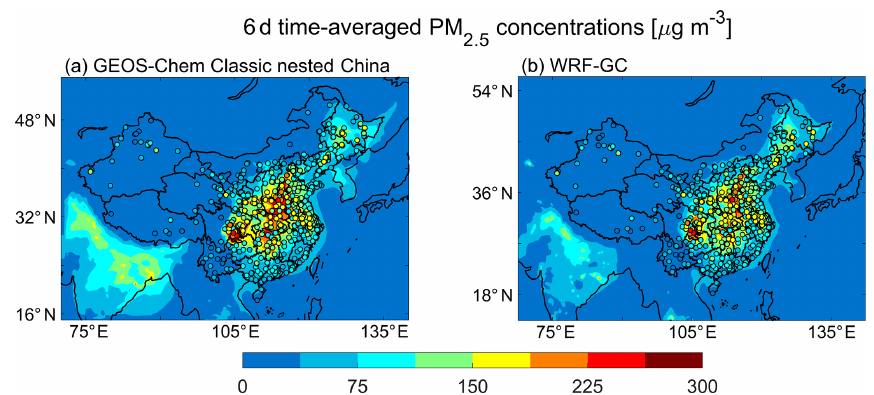
Figure 2. Comparison of the simulated (filled contours) 6d average PM 2 . 5 concentrations during 22 to 27 January 2015 from (a) the GEOS-Chem Classic nested-China simulation and (b) the WRF-GC nudged simulation. Also shown are the observed 6d average PM 2 . 5 concentrations during this period at 578 surface sites managed by the Ministry of Ecology and Environment of China. Table 2. WRF-GC physics